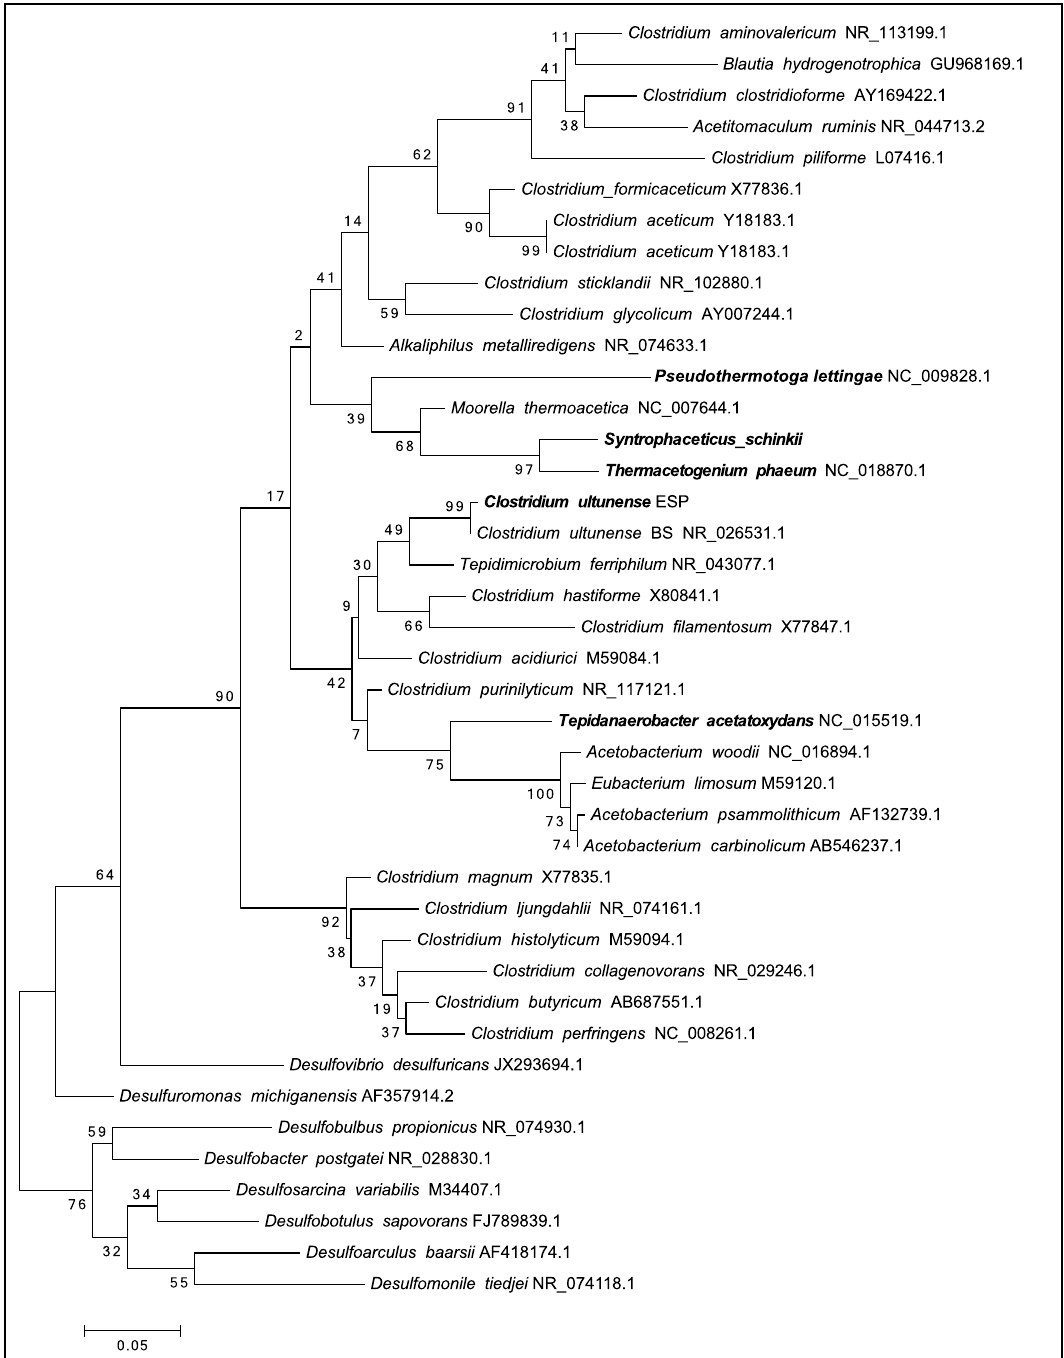
Figure 1. Maximum likelihood tree of the 16S ribosomal RNA (rRNA) gene showing the phylogenetic position of the syntrophic acetate-oxidising bacteria (SAOB) Clostridium ultunense , Syntrophaceticus schinkii , Tepidanaerobacter acetatoxydans , Pseudothermotoga lettingae , and Thermacetogenium phaeum related to acetogens and sulphate reducers.